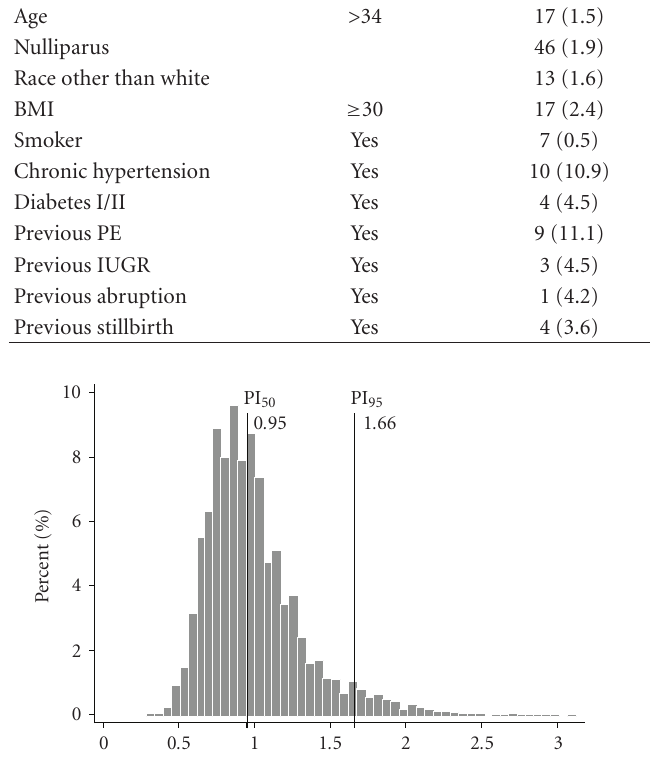
Figure 1: Frequency distribution of mean Pulsatility Index (mPI) uterine artery Doppler in the study